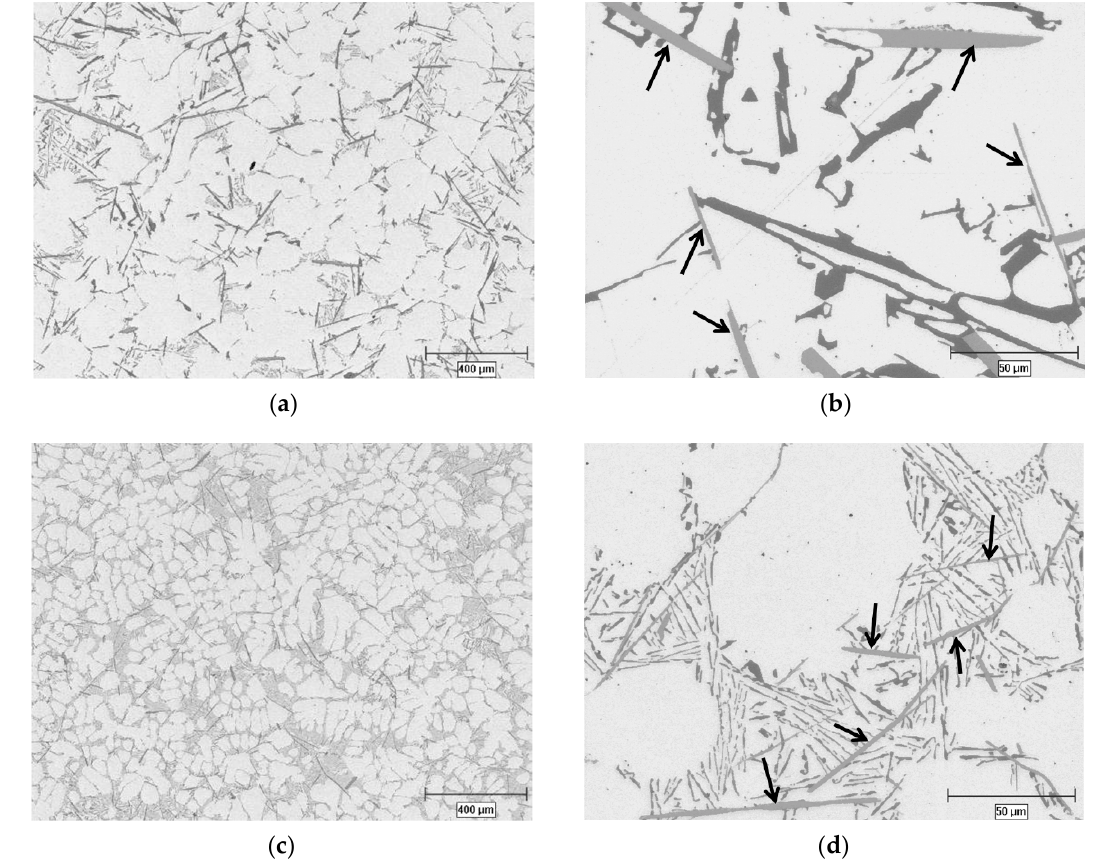
Figure 2. Optical micrographs showing the effect of cooling rate on the microstructure of as-cast magnetic stirring machine (EMS) billets: ( a , b ) sand mold and ( c , d ) copper mold, pouring temperature 690 °C, etched with 0.5% Hydrofluoric acid (HF) (arrows show some of the iron-intermetallics). Scale bar is 400 μ m for ( a ) and ( c ), 50 μ m for ( b ) and ( d ).